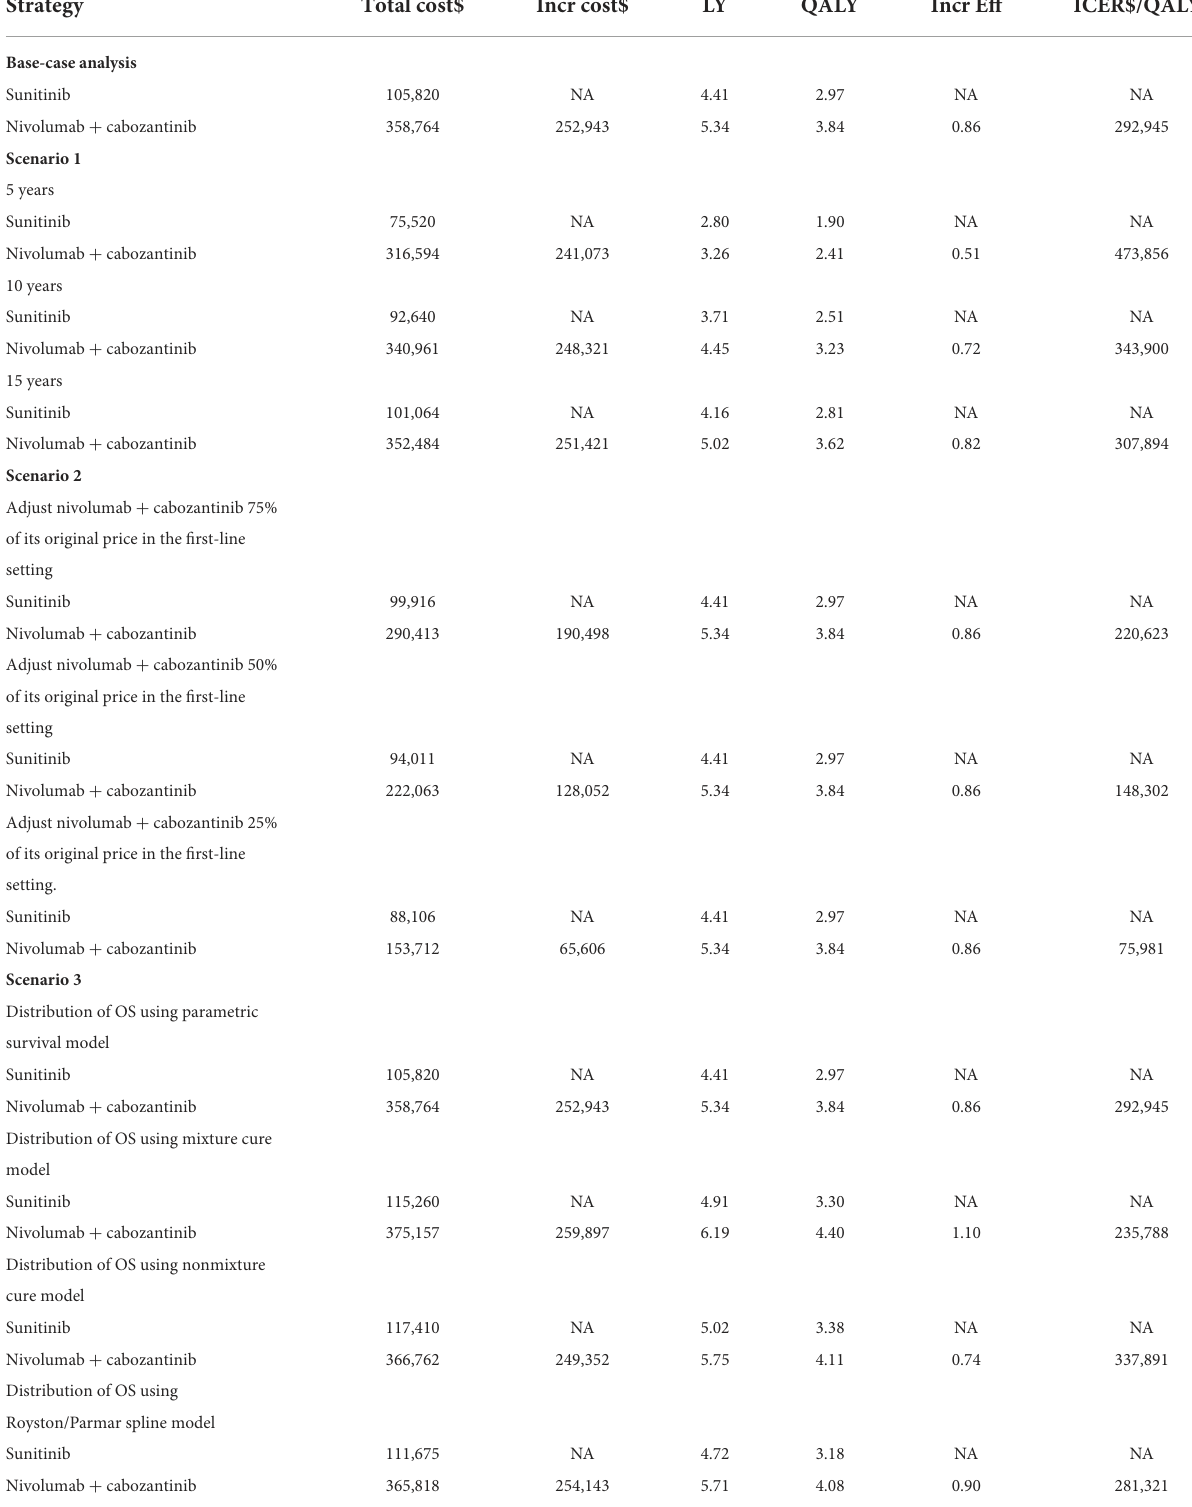
TABLE 2 Results of base-case and scenario